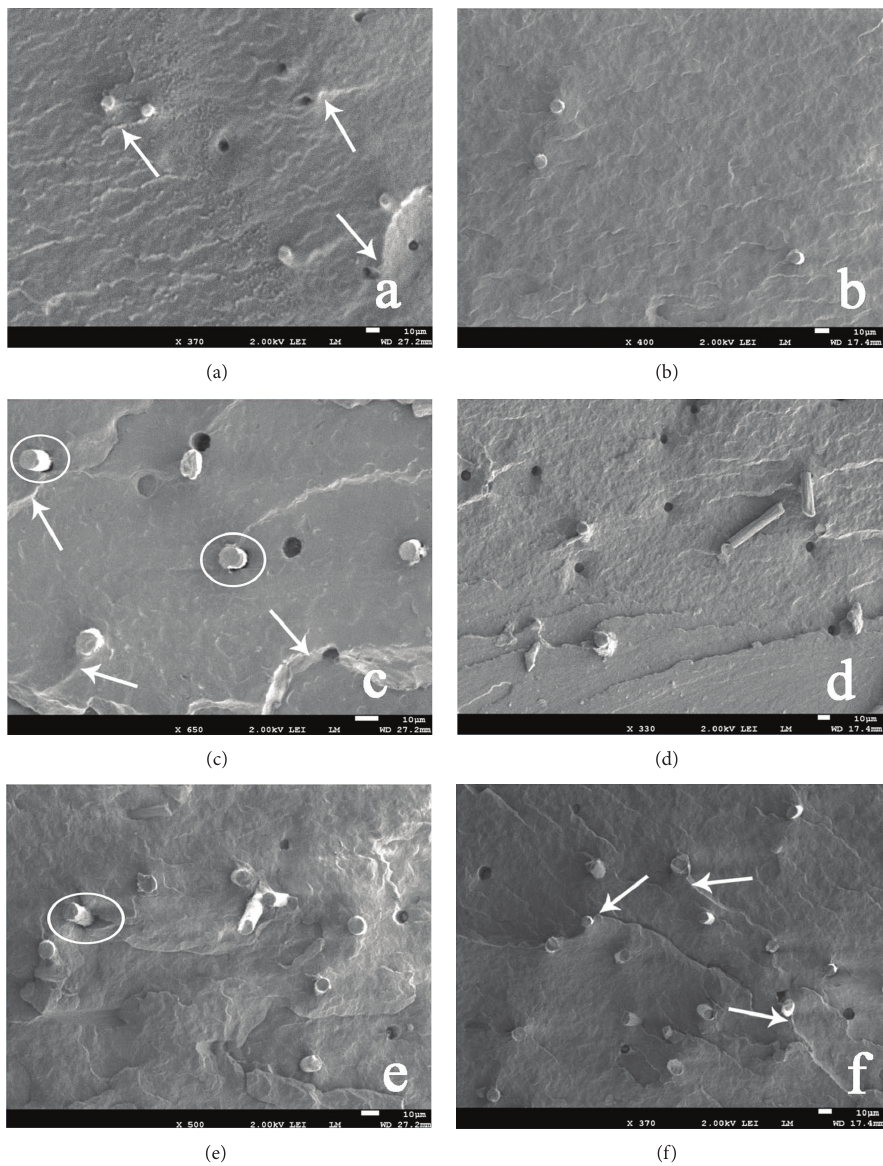
Figure 6: SEM images of the impacted samples: (a) 1 pph CF/PP, (b) 1pph CF/PP/PP-g-MAH, (c) 3 pph CF/PP, (d) 3 pph CF/PP/PP-g-MAH, (e) 5 pph CF/PP, and (f) 5pph